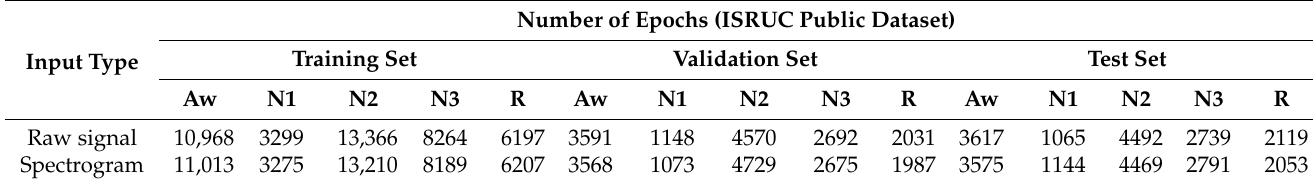
Table 1. Number of epochs of each sleep stage for training, validation, and